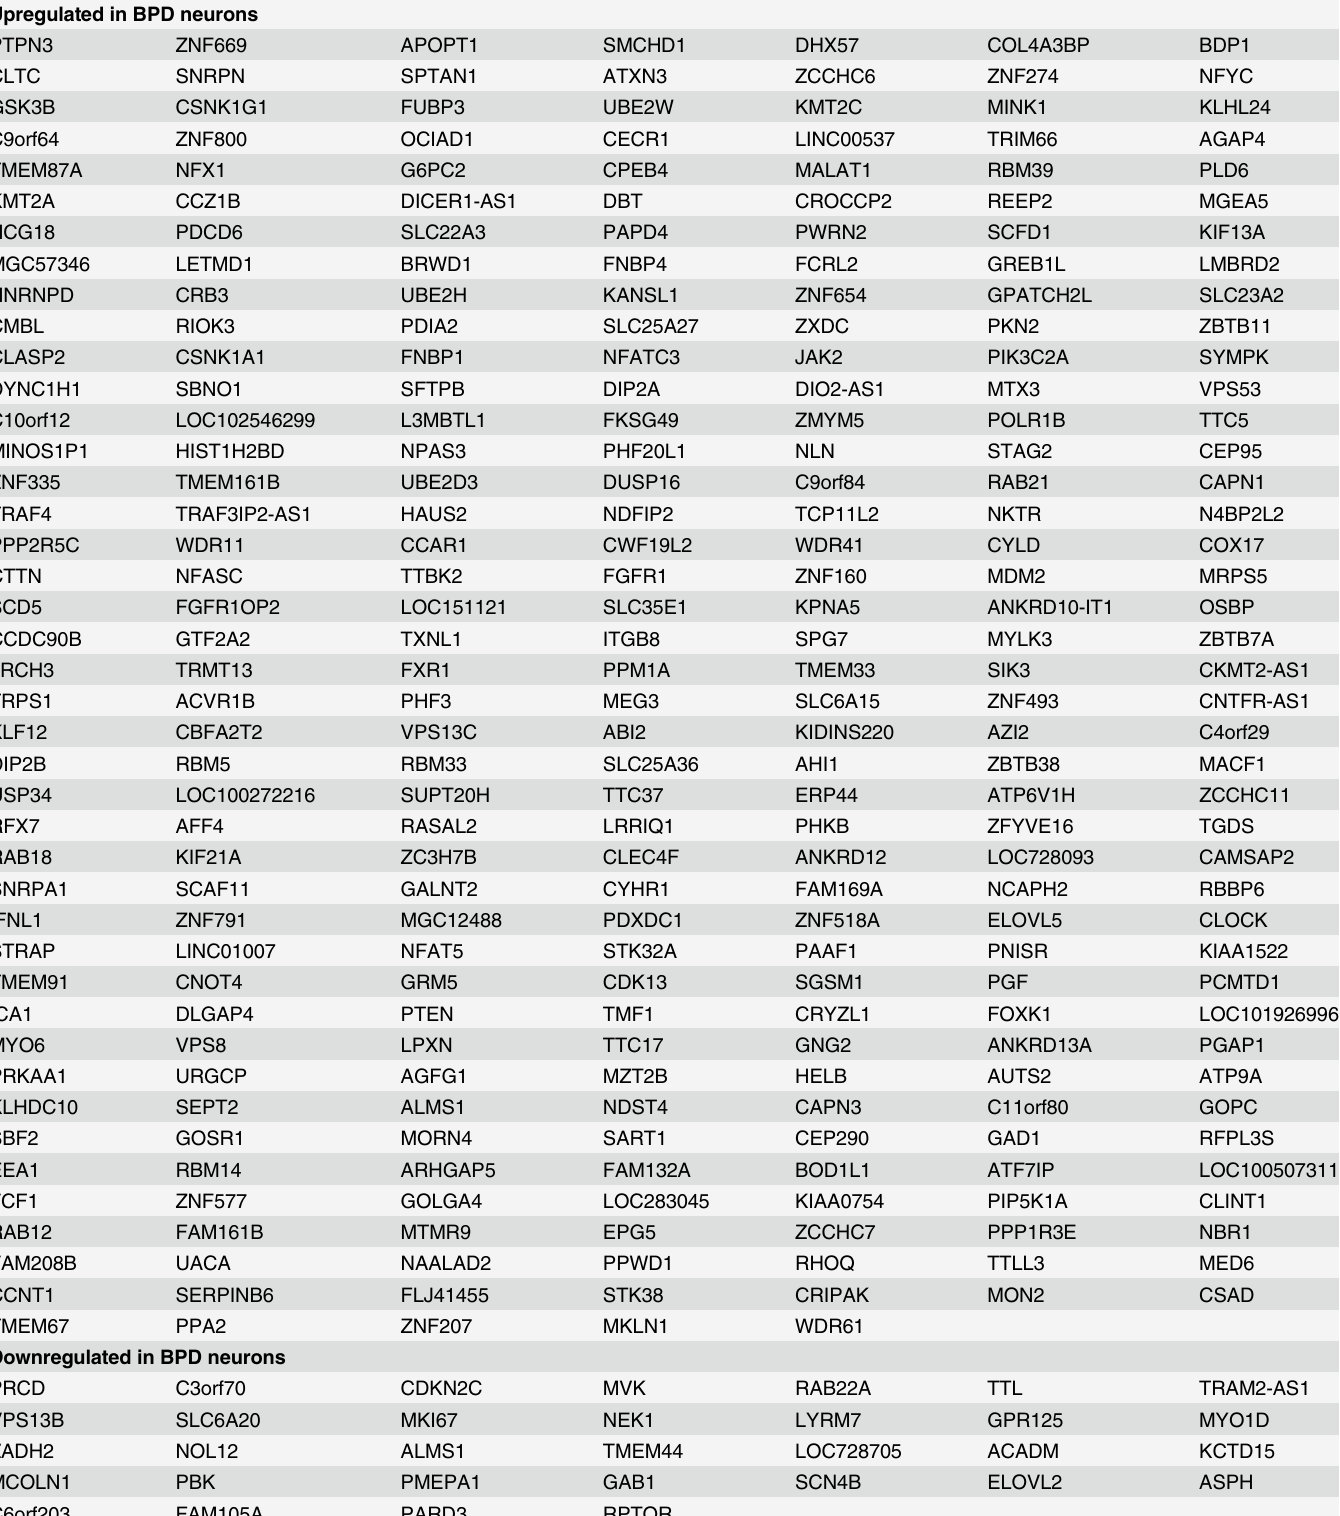
Table 1. List of differentially expressed genes (DEGs) in control and BPD L neurons. Upregulated in BPD